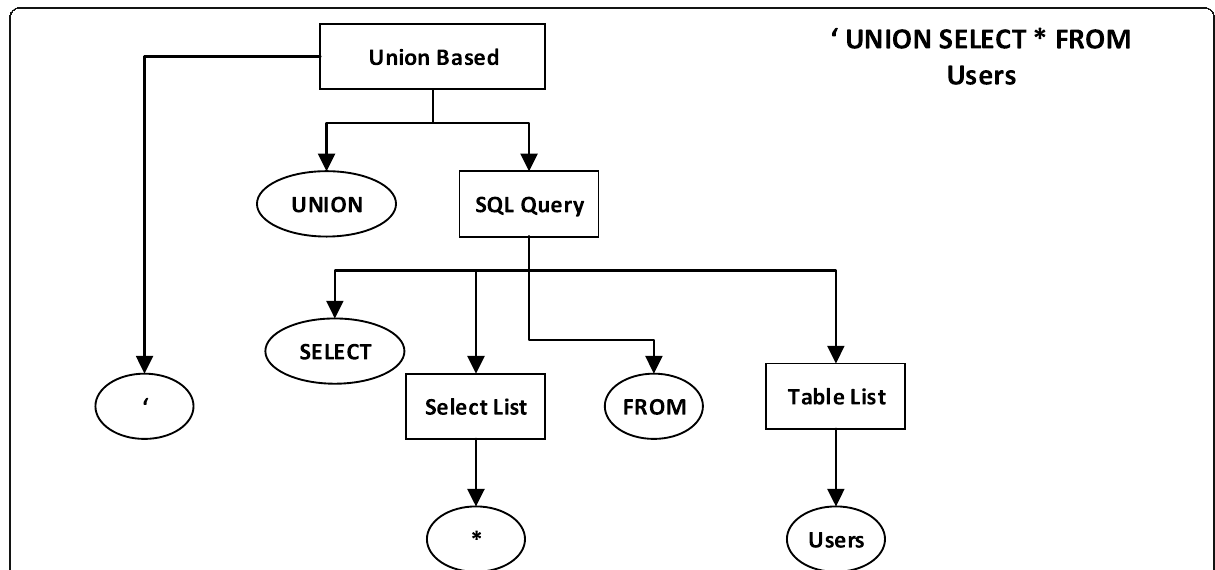
Fig. 2 A parse tree to depict union-based SQL injection attacks. (ii). Error-based SQL injection